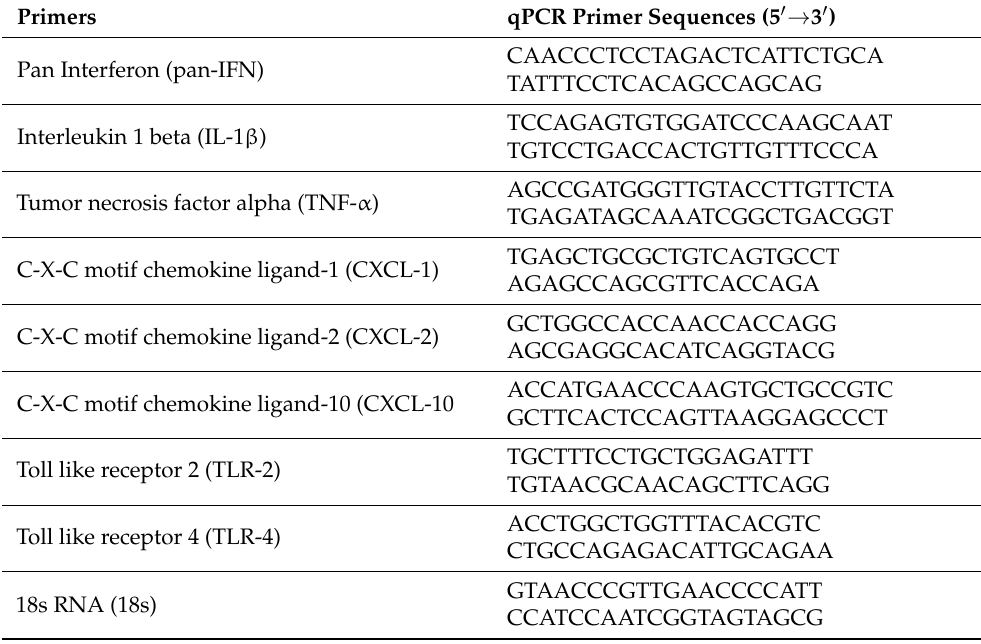
Table A1. Sequences of forward and reverse primers used in quantitative